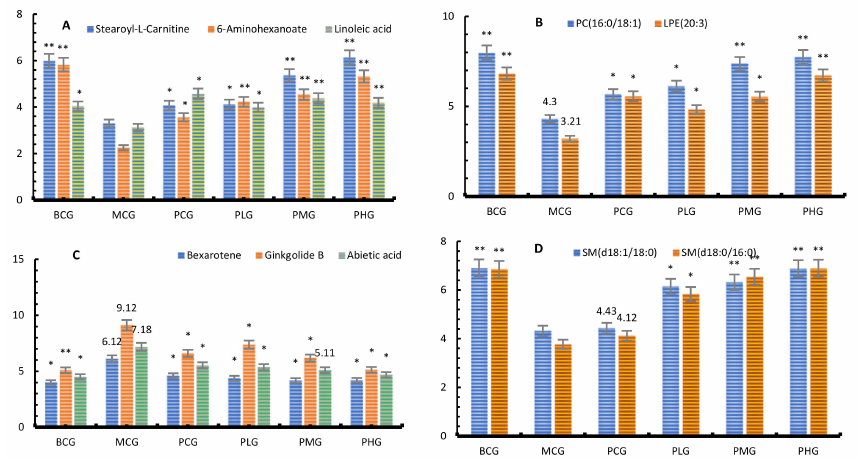
Figure 7. The relative content of 4 kinds of lipids (( A ): FAs; ( B ): PCs; ( C ): PLs; ( D ): SMs). Note: compared with model group, * p < 0.05, ** p <